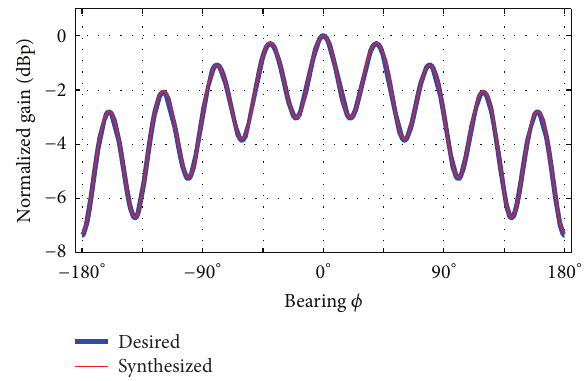
Figure 4: This paper’s synthesized 𝑡 = 0 co-pol array gain plotted over the desired pattern of (8) and [2].